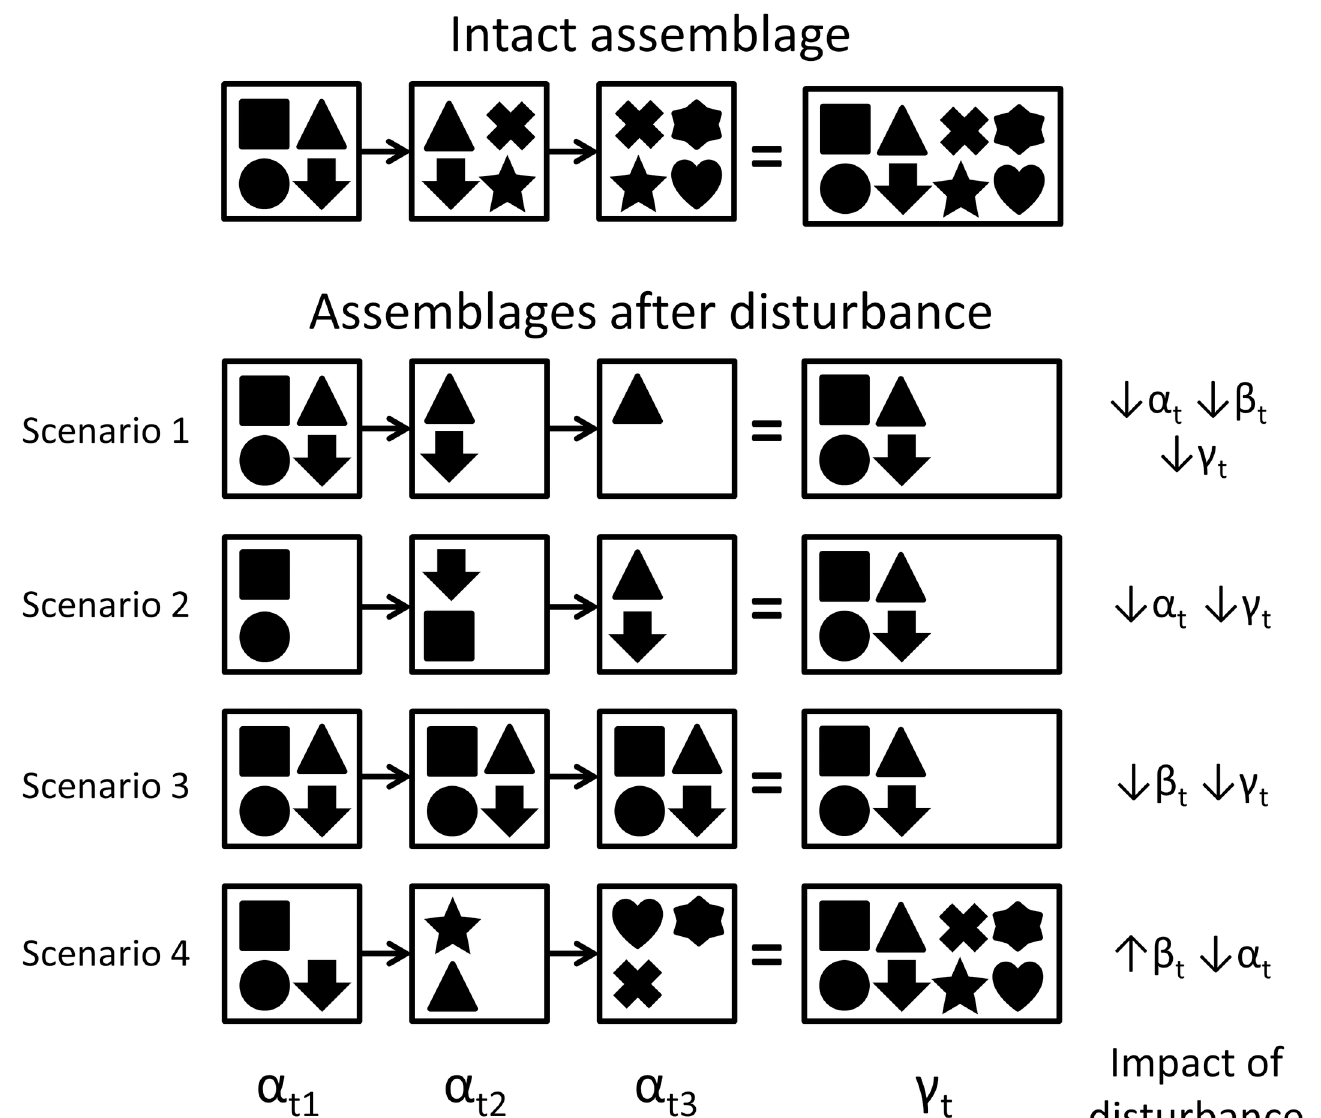
Fig 1. Hypothetical scenarios of disturbance impacting temporal gamma, alpha, and beta diversity of an assemblage. Each symbol represents a distinct taxon; α t represents taxon richness at discrete time points (t1-3), β t represents the turnover of taxa betweentime points, and γ t represents taxon richness summed across time